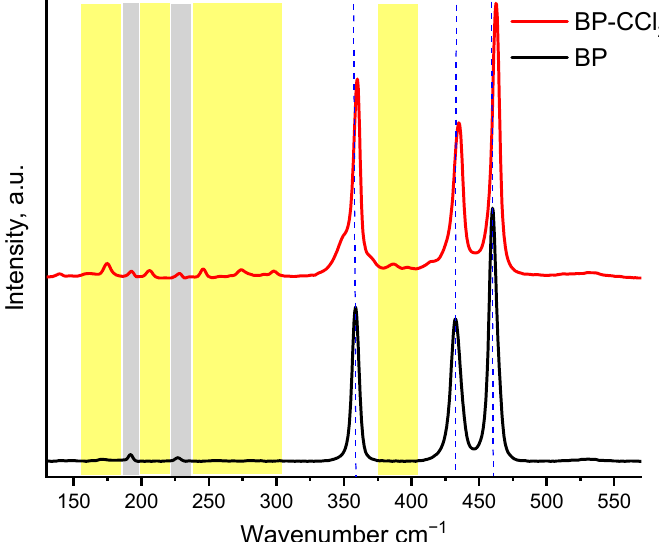
Figure 3. Raman spectra of BP and BP–CCl 2 . Dashed lines represent the peak positions of A 1g , B 2g , and A 2g phonon modes in BP, the regions of B 1g and B 13g phonon modes are highlighted in gray, and the distorted vibrations of the BP lattice in BP–CCl 2 caused by the functionalization of the material are highlighted in yellow.